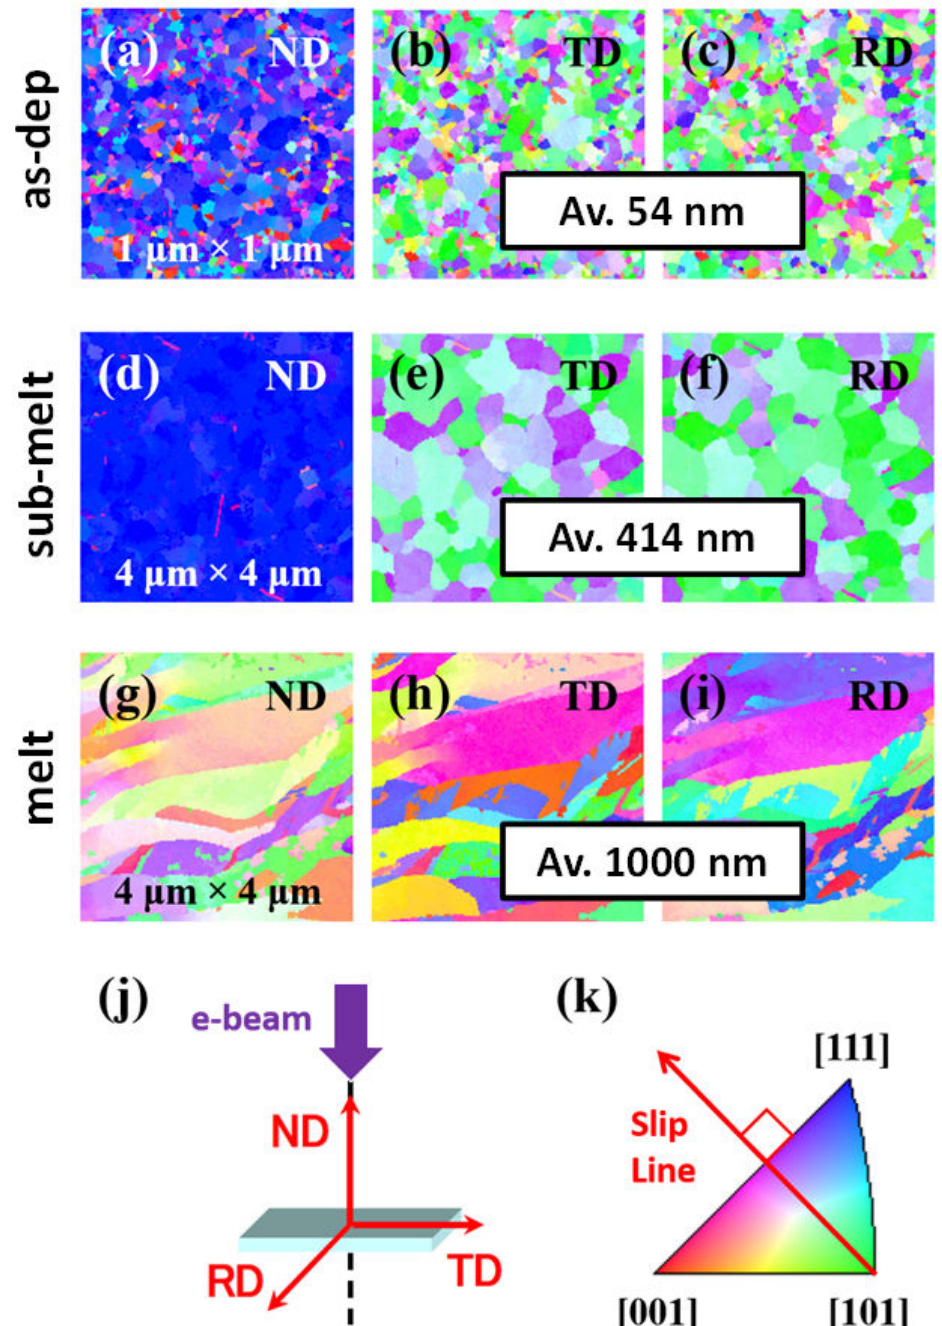
Figure 15. Images of electron diffraction mapping taken for the nonannealed ( a – c ) and annealed Cu thin films ( d – f ) are for a Cu submelt µ s UV-LA condition, whereas ( g – i ) are for a Cu melt µ s UV-LA condition. As depicted in ( j ), ND, TD, and RD stand for normal direction, transverse direction, and reference direction, respectively. Moreover, a standard triangle of grain orientations is shown in ( k ). Reprinted/adapted with permission from Ref. [79]. 2021,